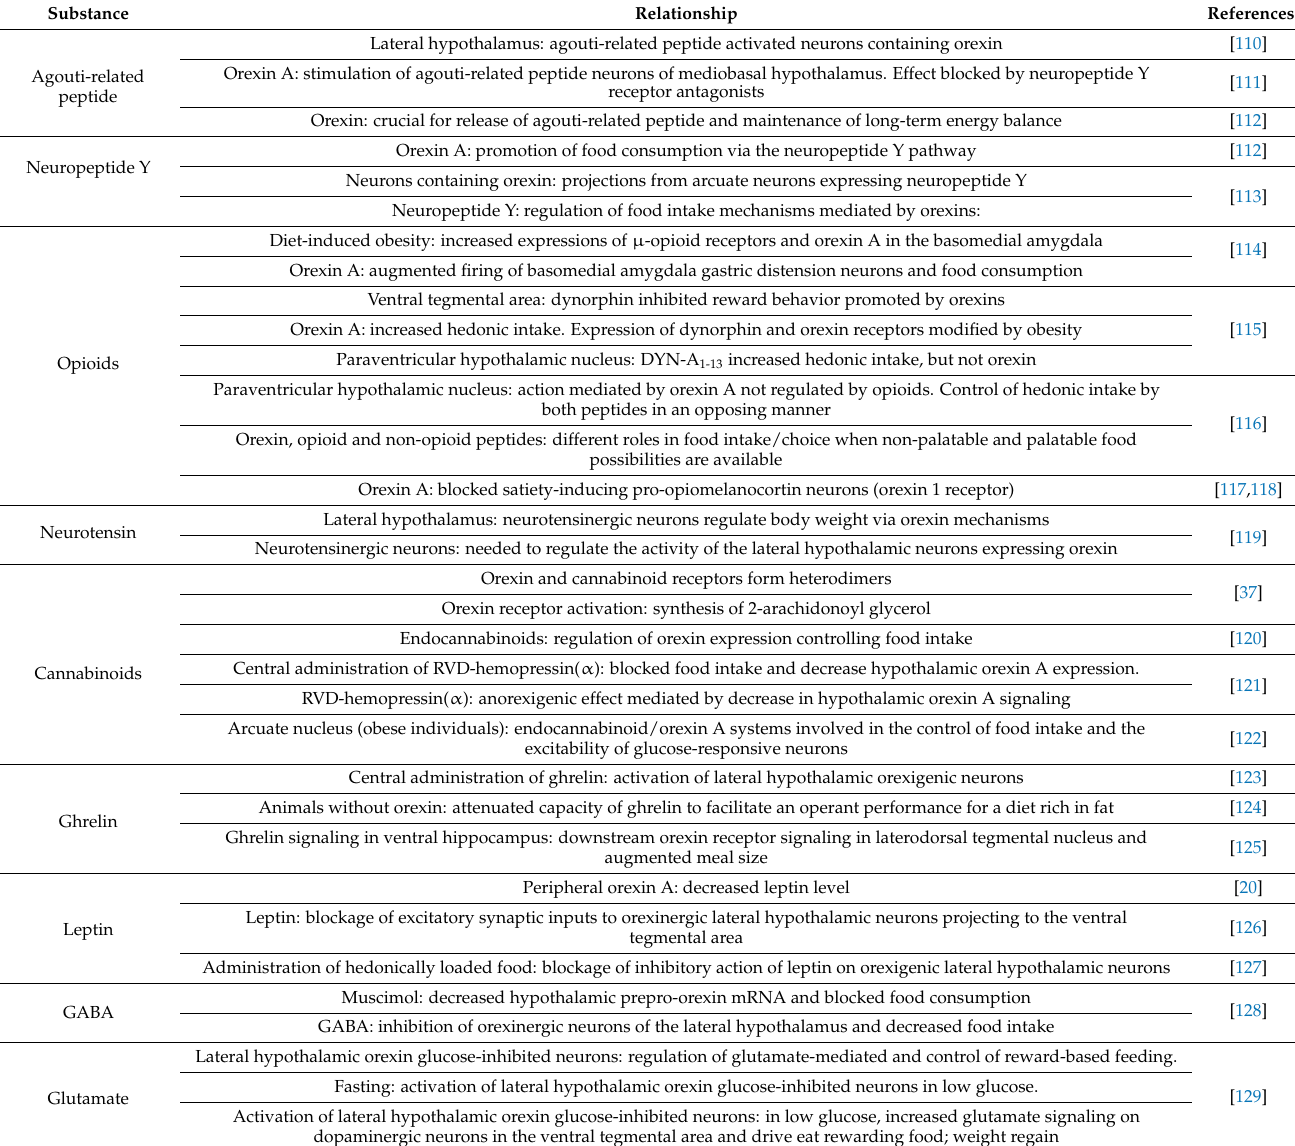
Table 5. Orexins and other substances: